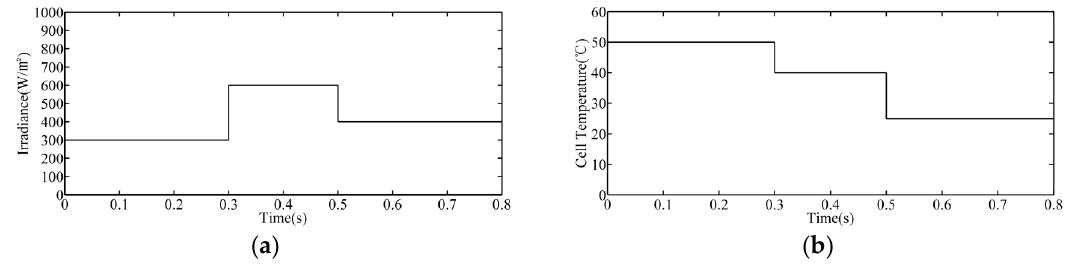
Figure 15. Fast variations of ( a ) solar irradiance and ( b ) solar cell temperature.